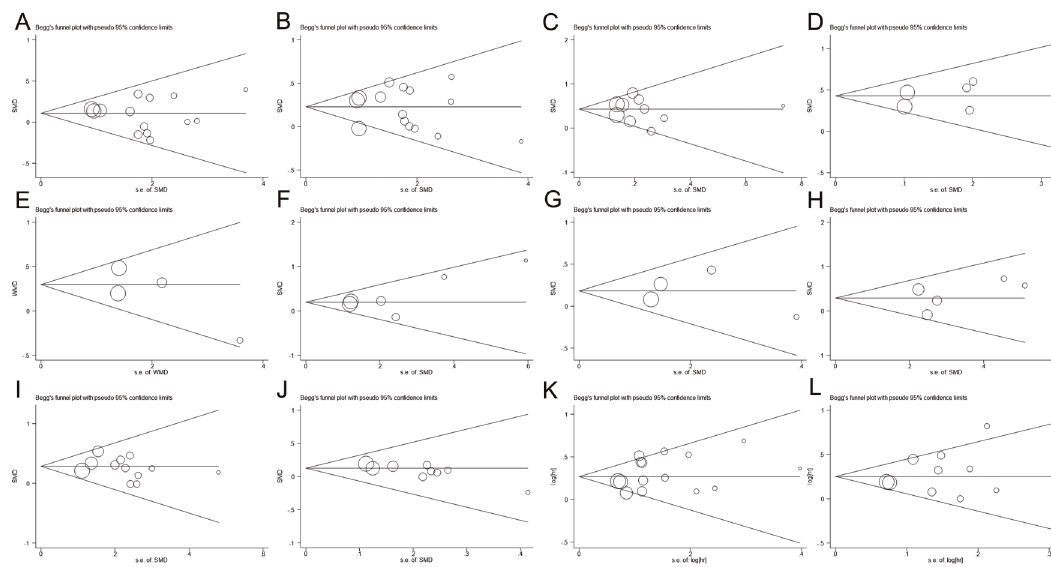
Figure 4 - The results of publication bias for patient ( A ) age ( o =65/ 4 65), ( B ) sex (male/female), ( C ) smoking status (yes/no), ( D ) T stage (T2/T1), ( E ) T stage (T3-T4/T1-T2), ( F ) N stage (N1/N0), ( G ) N stage (N2-N3/N0-N1), ( H ) M stage (M1/M0), ( I ) AJCC stage (stage II/stage